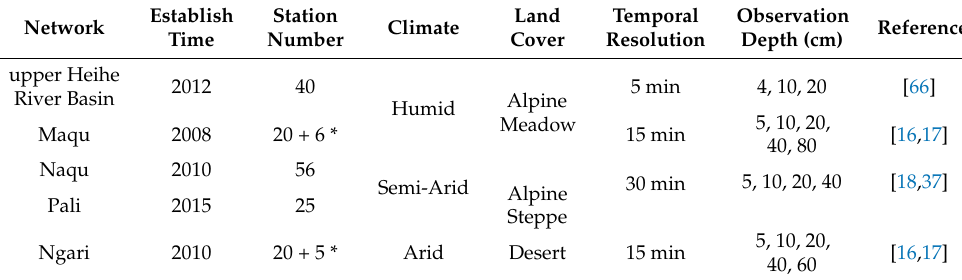
Table 3. Basic information of SM observation networks on the